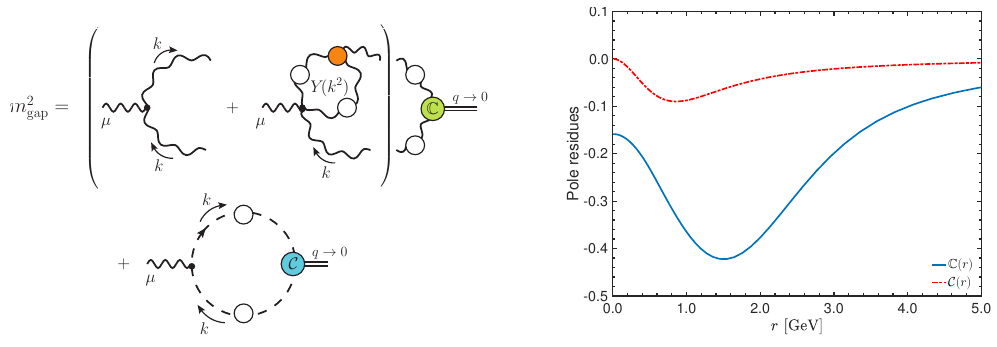
Figure 9: Left panel: Diagrammatic representation of eq. (103). Right panel: the momentum dependence of (cid:67) ( q 2 ) and